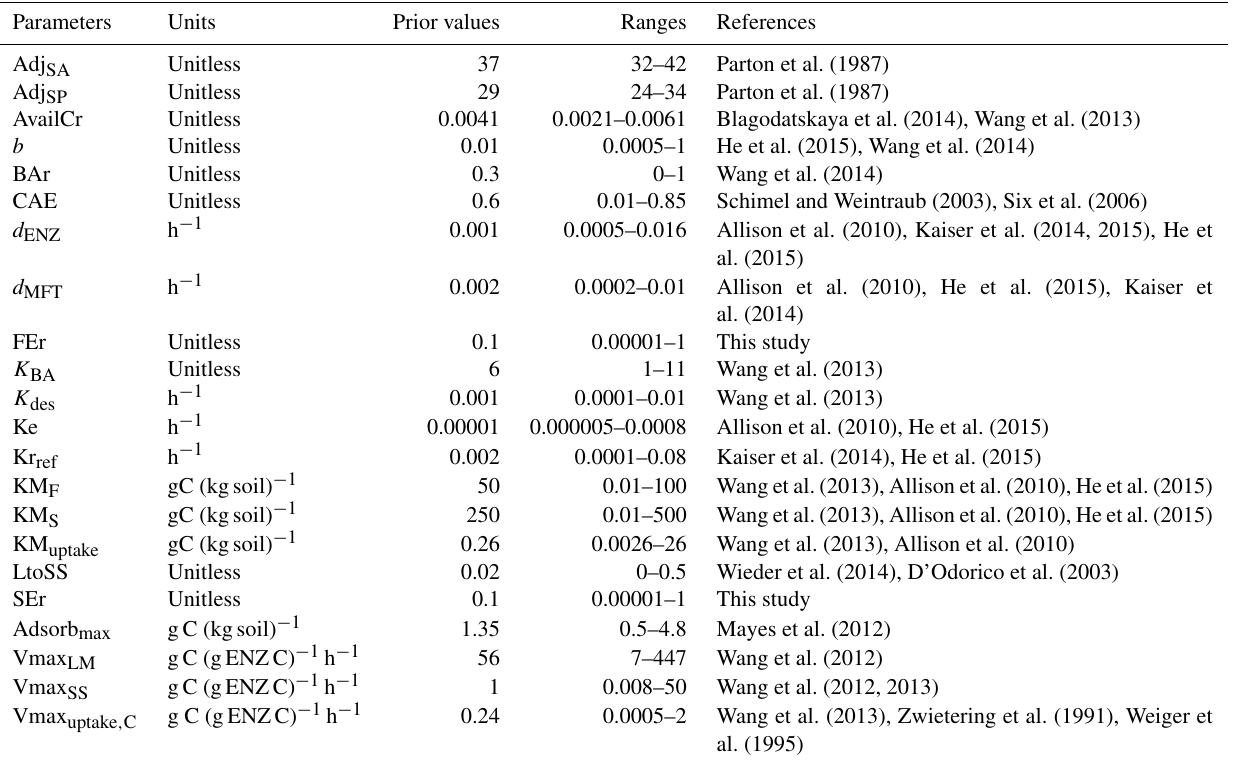
Table 2. List of optimized parameters with their prior values and ranges; for the description of each parameter see Table 1. Parameters